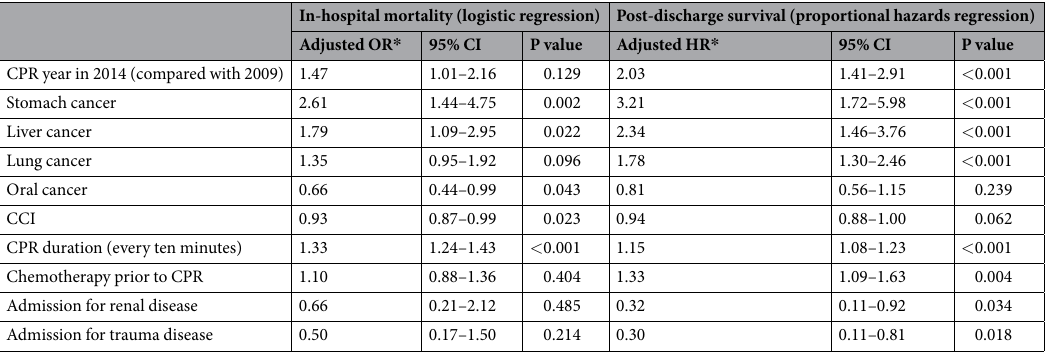
Table 2. Independent prognostic factors of in-hospital mortality and post-discharge survival. Note: CCI, charlson comorbidity index; CI, confidence interval; CPR, cardiopulmonary resuscitation ; HR, hazard ratio; OR, odds ratio. * Variables in the model included year of CPR, cancer types, primary disease for admission, gender, age, socioeconomic status, cardioversion, radiotherapy prior to CPR, chemotherapy prior to CPR, and cancer diagnosis to